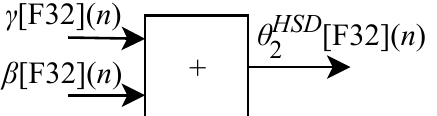
[ F 32 ]( n ) angular position 2